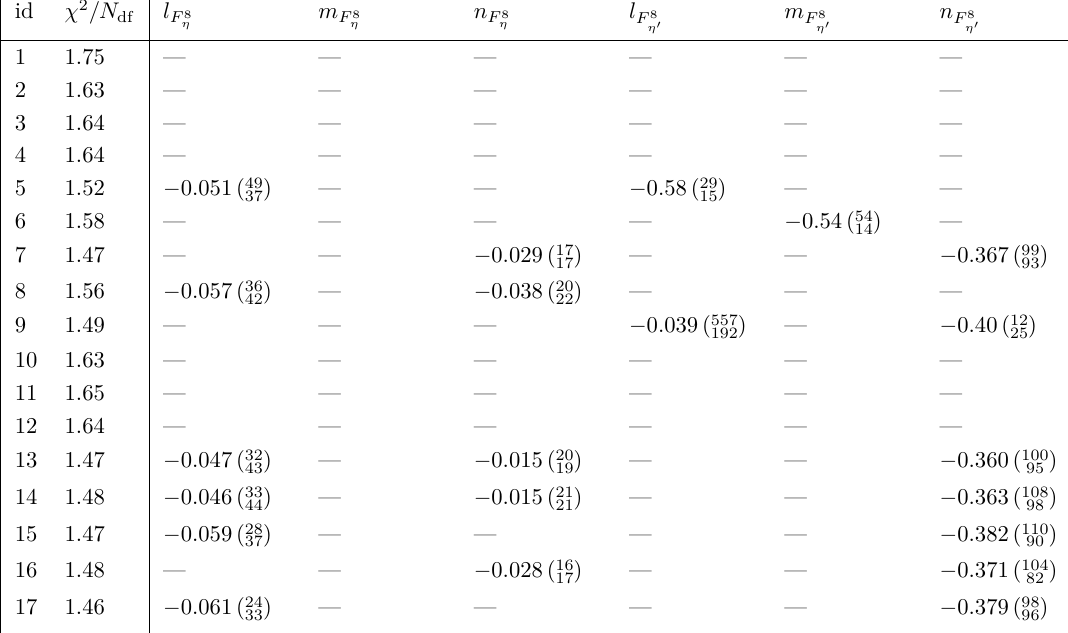
Table 22. Fit parameters, accompanying quadratic lattice effects for the octet decay constants, see eq. (5.53). The fit ids are defined in table